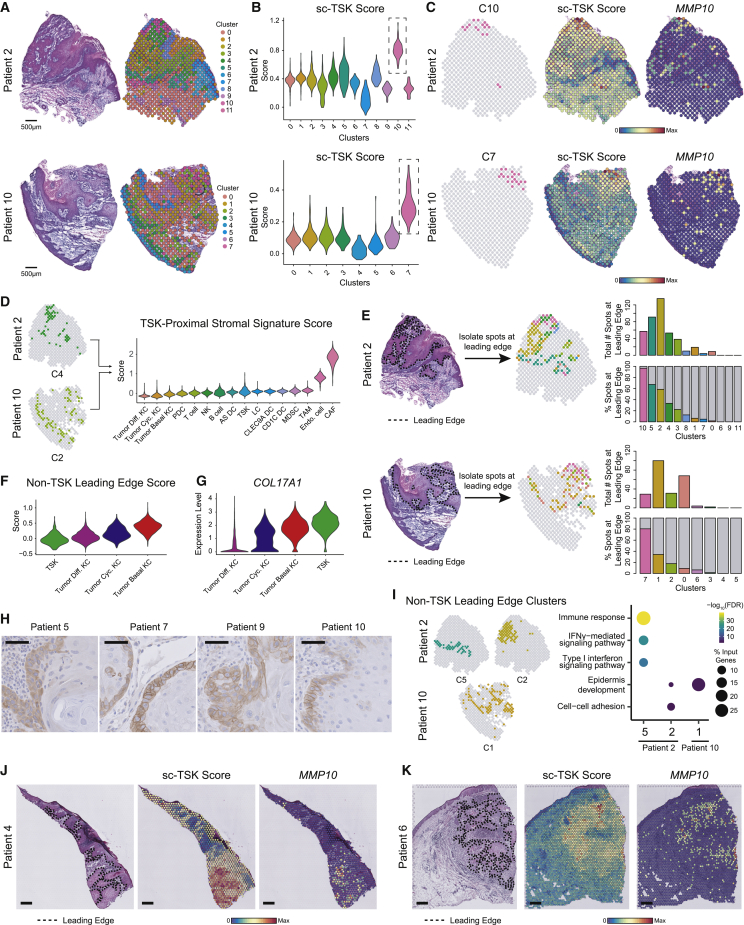
Leading Edge Heterogeneity Revealed by Spatial Transcriptomics(A) Hematoxylin and eosin (H&E) staining of tissue sections and unbiased clustering of ST spots. Scale bar, 500 μm.(B) Violin plots of TSK scores of individual spots derived from scRNA-seq data (sc-TSK score) for each cluster. Dotted boxes outline clusters with highest average sc-TSK score.(C) Spatial feature plots of TSK-high cluster, sc-TSK score, and TSK marker MMP10 expression in tissue sections.(D) Violin plots of TSK-proximal signature score (intersection of differentially expressed genes in patient 2 cluster 4 and patient 10 cluster 2, n = 34 genes) for cell types in scRNA-seq data.(E) Left, H&E staining with leading edge of tumor annotated (dotted lines) and isolated leading edge spots labeled by cluster. Right, bar plots of total number and percentage of spots at leading edge per cluster.(F) Violin plots of non-TSK leading edge signature score (intersection of differentially expressed genes of non-TSK spots at leading edge from patient 2 and patient 10, n = 6 genes) by tumor subpopulations.(G) Violin plots of COL17A1 expression by tumor subpopulation in scRNA-seq data.(H) Immunohistochemical staining of COL17A1 in patient tumors. Scale bar, 50 μm.(I) Projection of non-TSK leading edge-associated clusters with dot plot of select gene ontology (GO) terms of differentially expressed genes in each cluster (n = 200 genes for patient 2 clusters, n = 20 for patient 10 cluster).(J and K) H&E, sc-TSK score, and MMP10 expression feature plots from (J) patient 4 and (K) patient 6 with data generated using the Visium ST platform.Scale bar, 500 μm. KC, keratinocyte; TAM, tumor-associated macrophage. See also Figure S3 and Table S4.